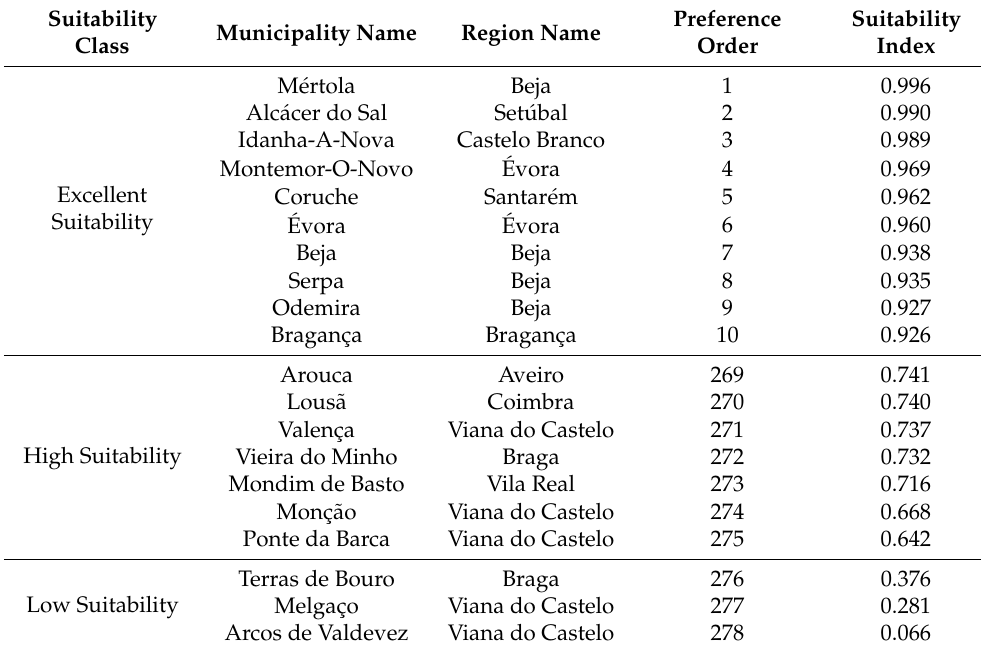
Table 5. The most and least suitable municipalities for PV deployment in the Portuguese mainland according to their SI.